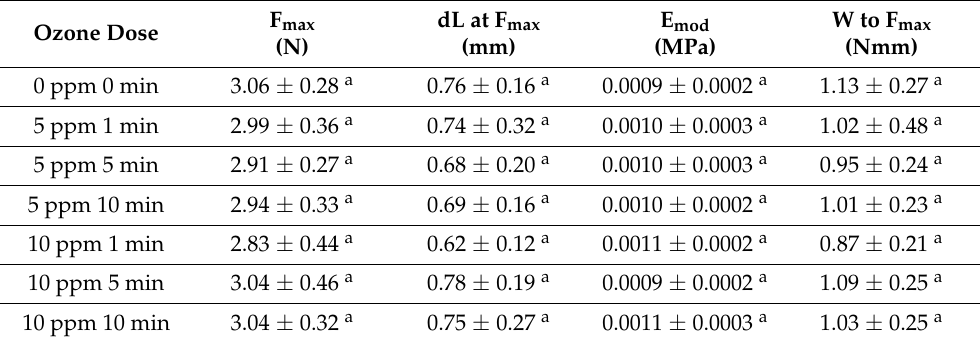
Table 1. Value of destructive force F max (N), deformation dL at F max (mm), elastic modulus E mod (MPa) and work performed to achieve maximum destructive force W to F max (Nmm) in leaves of Kalanchoe daigremontiana in process of puncture test performed with indenter, diameter of ϕ = 4 mm (n = 30; ±